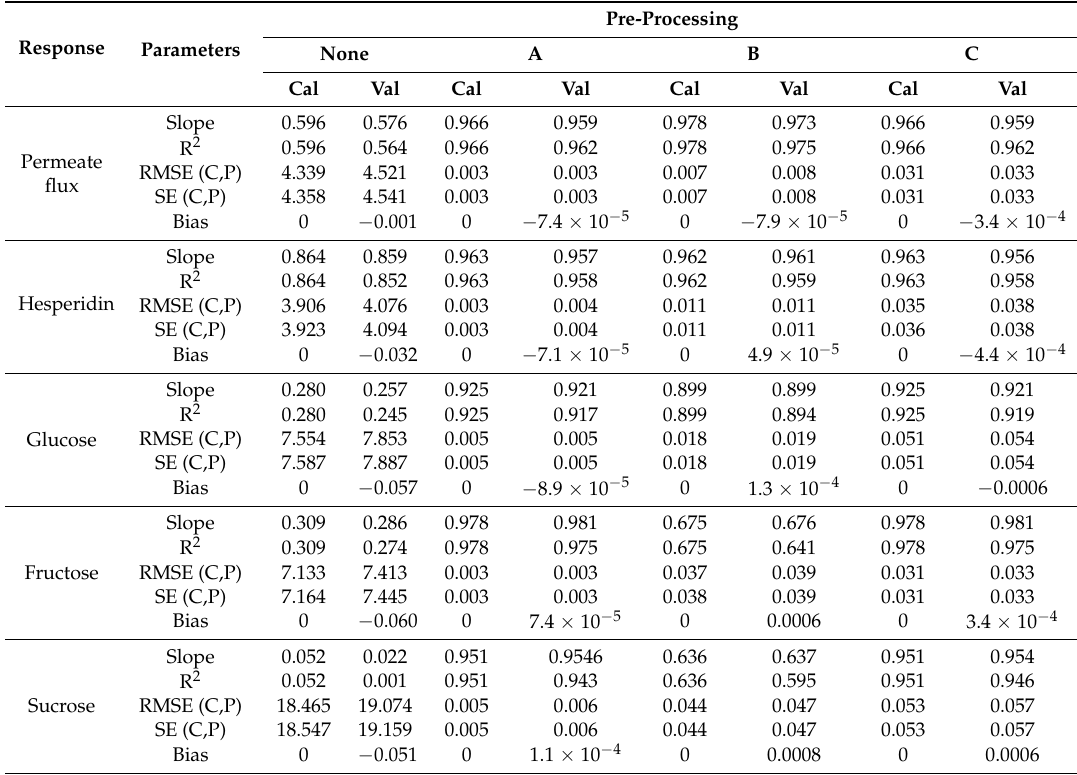
Table 3. Comparison of various pre-processing methods for the PLSR modeling. Pre-processing: A: Normalize (area normalization) and moving average; B: Normalize (unit vector normalization) and moving average; C: Normalize (mean normalization) and moving average (Cal: Calibration data set; Val: Validation data set).